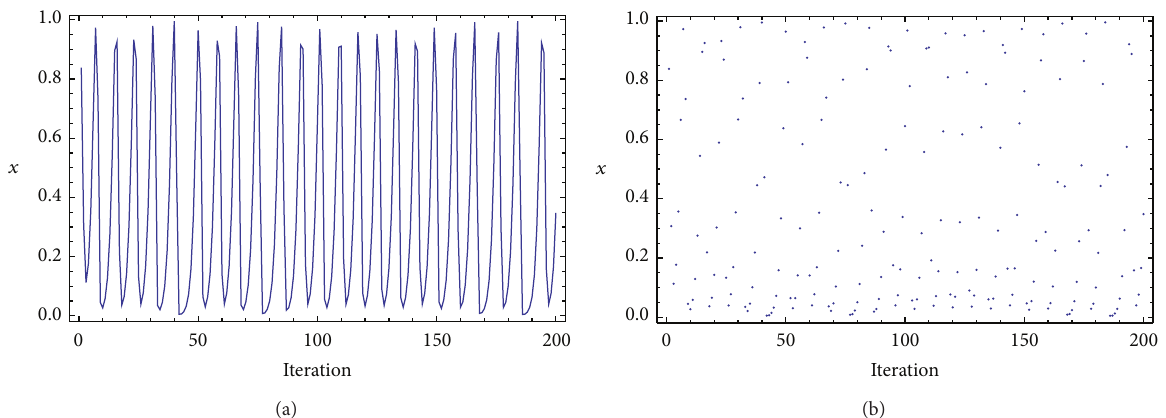
Figure 5: Iterations of the delayed logistic (variable 𝑥 ) (a), iterations of the delayed logistic (variable 𝑥 ), point-plot (b).